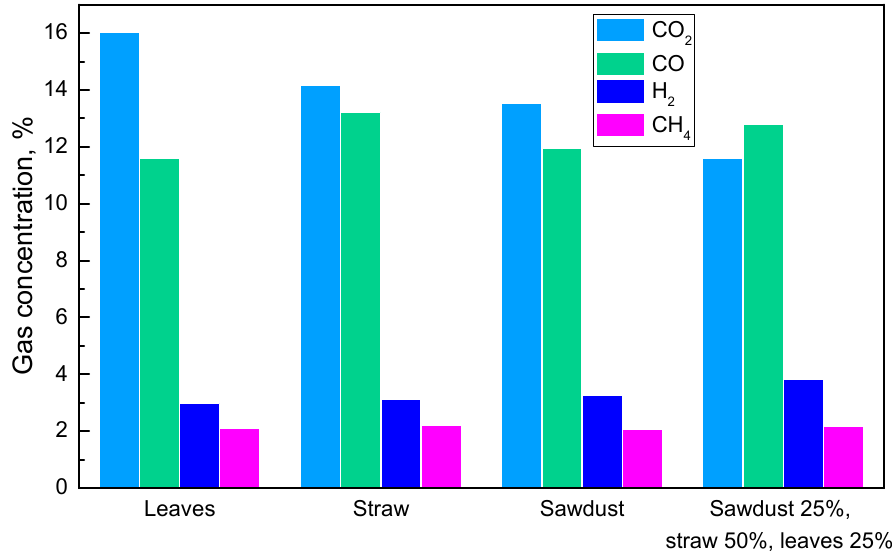
Figure 2. Gas composition during pyrolysis of different types of biomass.